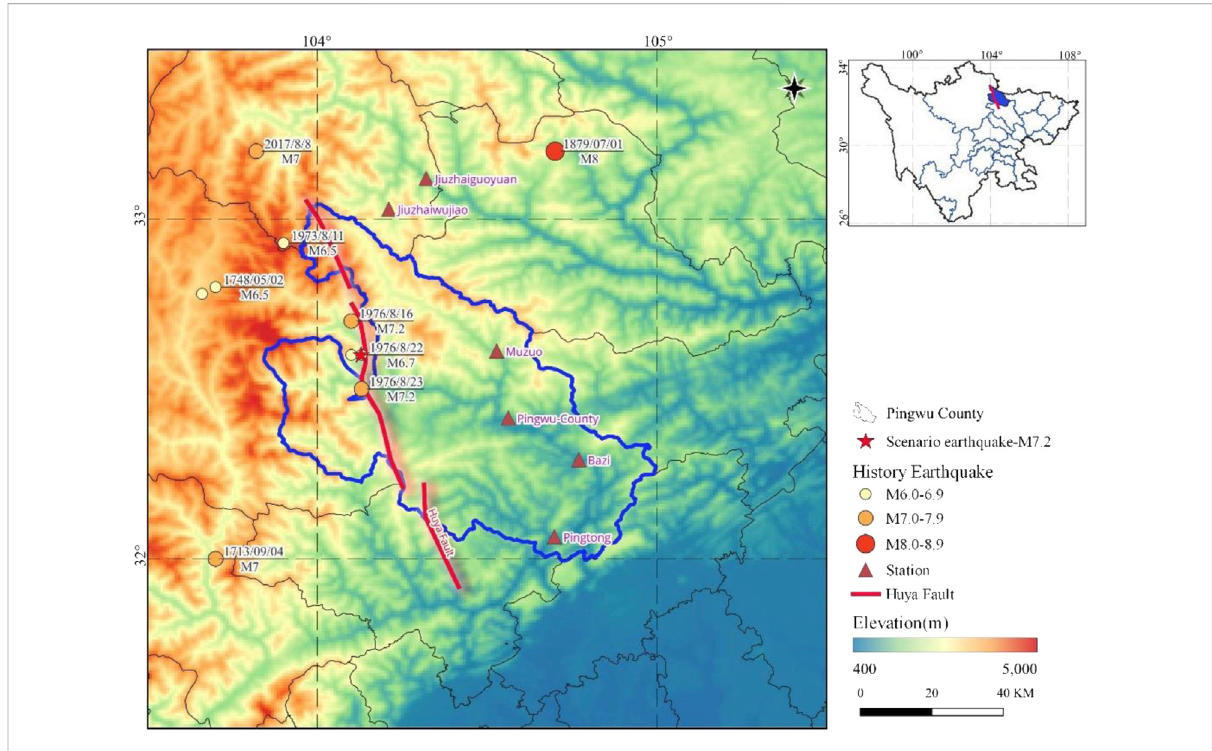
FIGURE 1 Maps showing the tectonic setting of the Pingwu